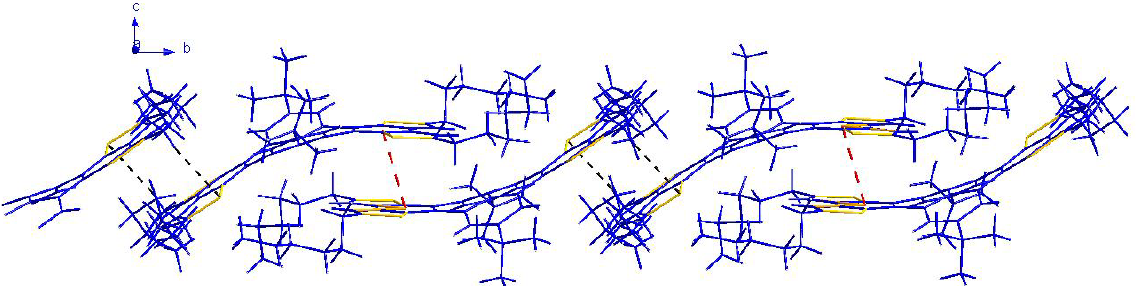
Figure 8. View of the one-dimensional supramolecular framework of THTP-C along the b axis. The π - π and CH-S interactions are represented by dashed red and black lines,